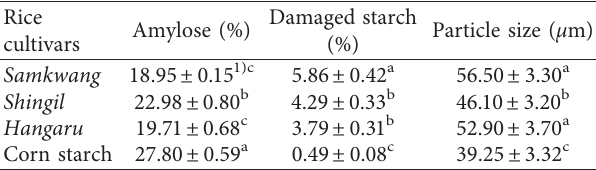
Table 1: Proximate compositions, amylose content, damaged starch content, and particle size of different rice flours.